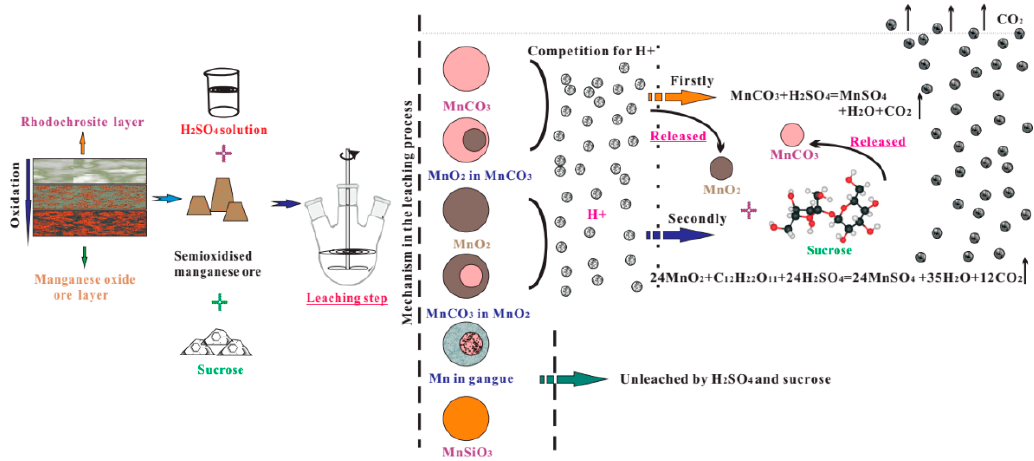
Table 2. Content of insoluble manganese phase in residues.